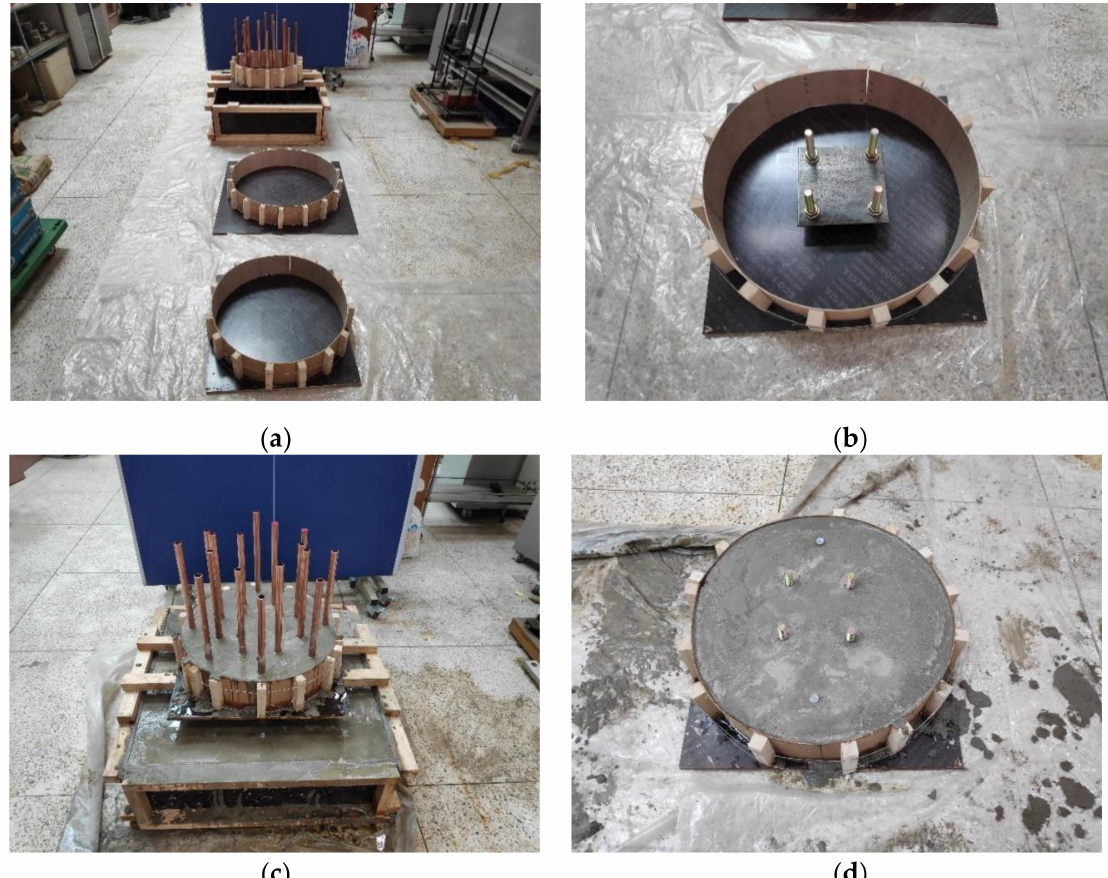
Figure 2. Wind turbine foundation and bedrock production: ( a ) cement mortar form; ( b ) buried the connection bolt for the wind turbine tower; ( c ) cement mortar placement for wind turbine foundation and bedrock; ( d ) existing wind-based mortar